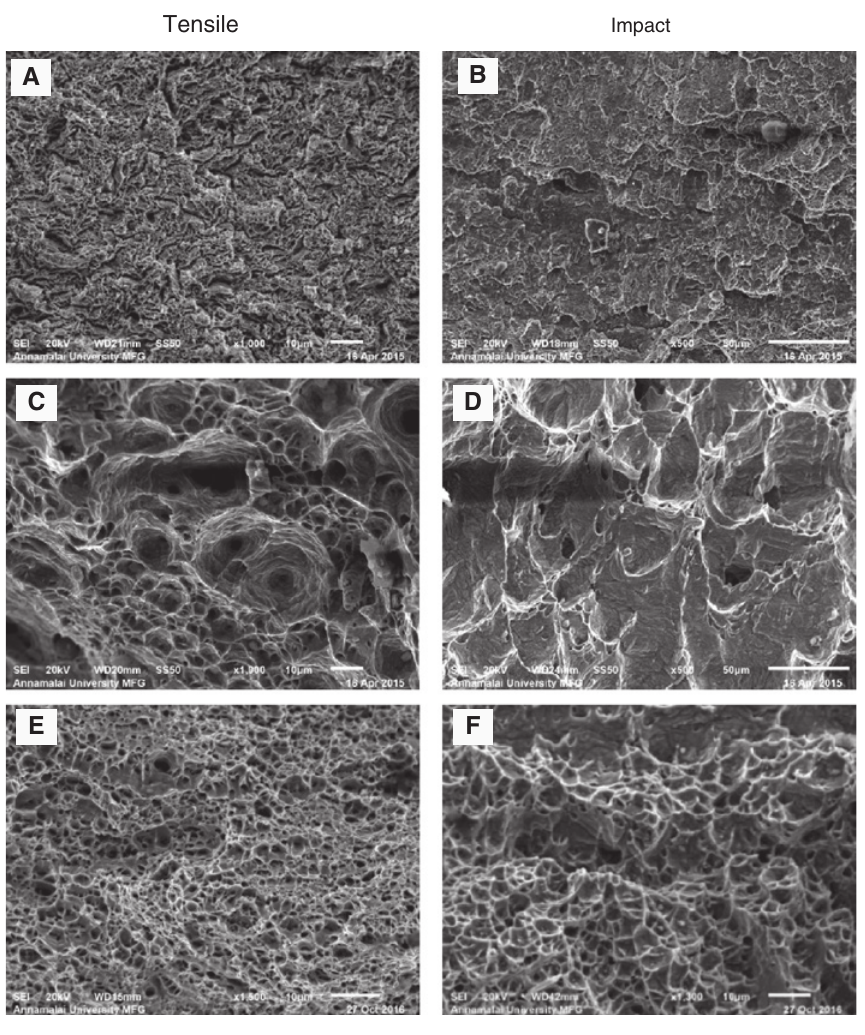
Figure 5: SEM fractographs of tensile and impact specimens. (A and B) Ferritic steel – BM, (C and D) Austenitic stainless steel – BM, (E and F)